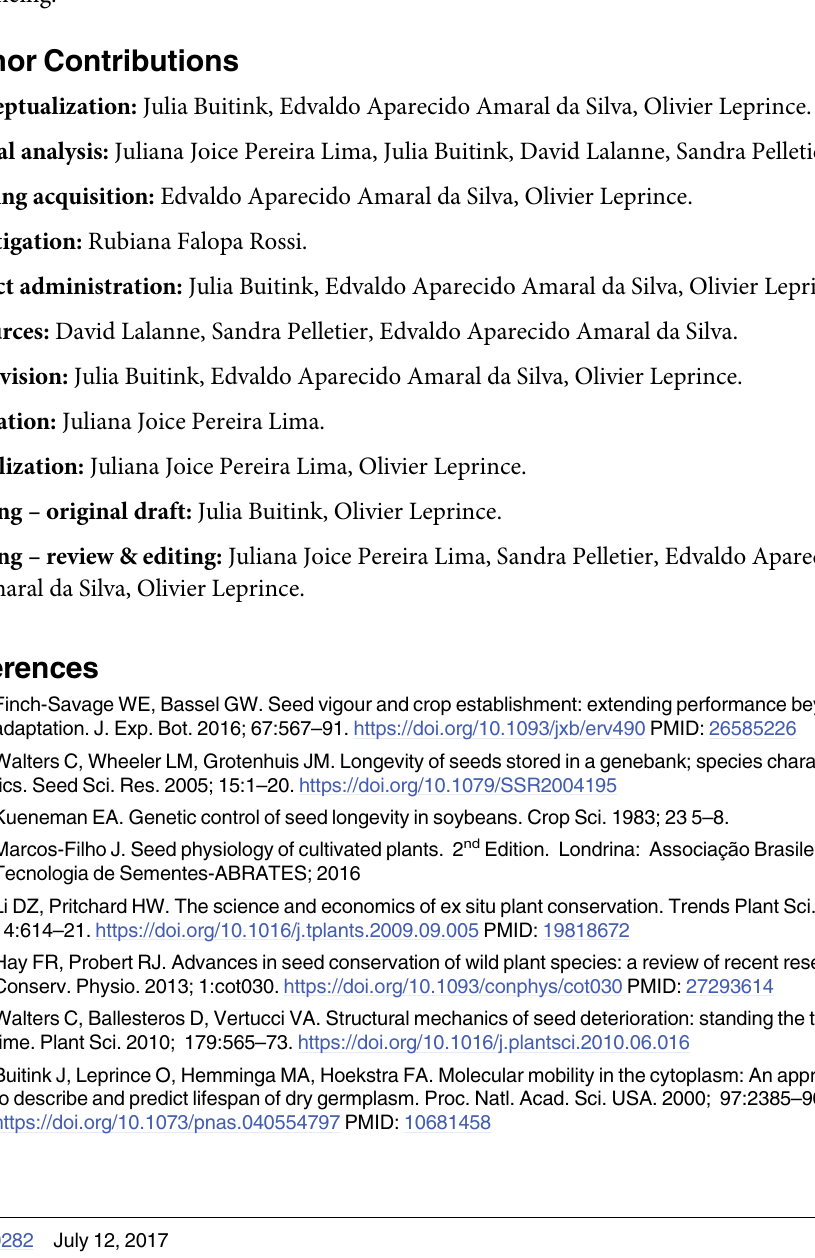
S4 Table. Transcription factors present in the co-expression network of soybean seed mat- uration. Genes with expression profiles that correlate with longevity (P50, PCC > 0.9) are indi- cated in bold with a blue background. S5 Table. List of differentially expressed genes associated with longevity. List of differen- tially expressed genes that are higher/lower in mature seeds exhibiting maximal longevity (stage 9) compared to dried immature seeds (stage 7.2D) with low